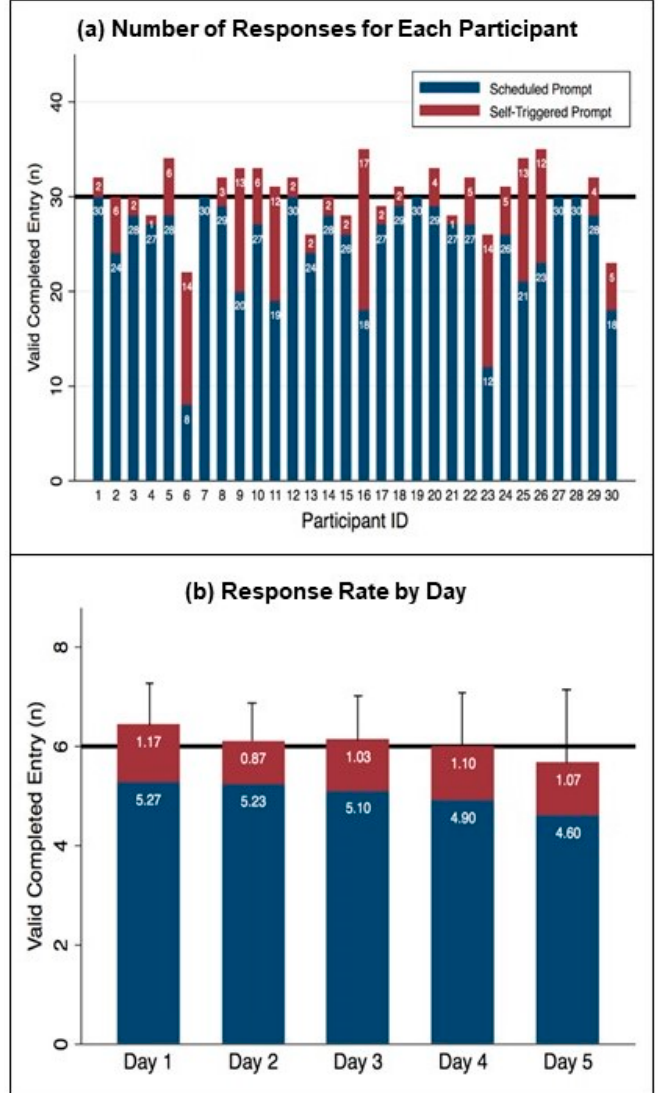
Figure 2. High feasibility of EMA response rate for scheduled (Blue) and self-triggered (Red) prompts. ( a ) Number of responses for each participant. The goal of 30 prompts during participation (6 prompts/day for 5 days) is indicated by the black horizontal line. ( b ) Response rate by day. The goal of 6 prompts per day is indicated by the black horizontal line. The error bars represent the standard deviation of each bar.